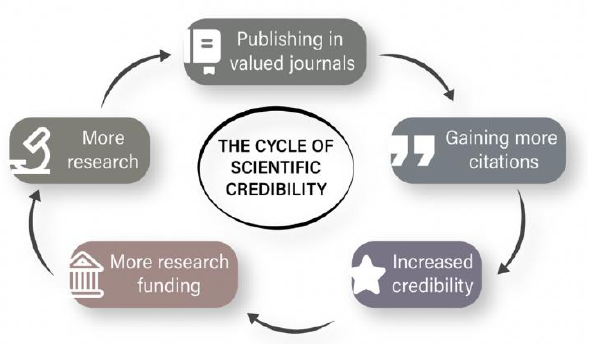
Figure 1. Simplified conceptual diagram representing the cycle of scientific credibility as described in Latour (2003). accumulation of capital and credibility. Based on Marx, he calls capital “ what circulates within a cycle and has no other goal than the expansion of this cycle ” (Latour 2003: